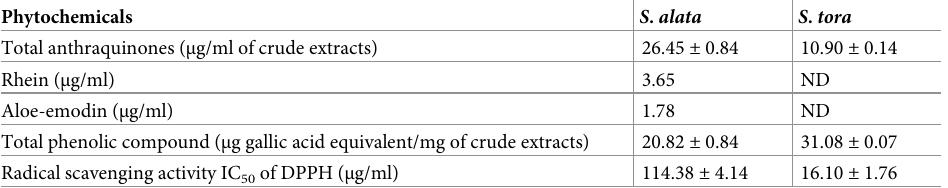
Table 1. Total contents of anthraquinones, rhein, aloe-emodin, phenolic compounds, and antioxidation of S . alata and S . tora